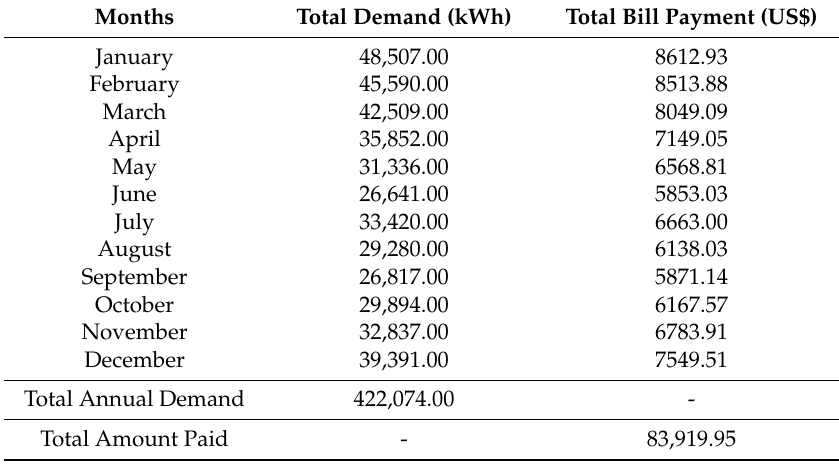
Table 2. Total demand and total bill payment of each month in